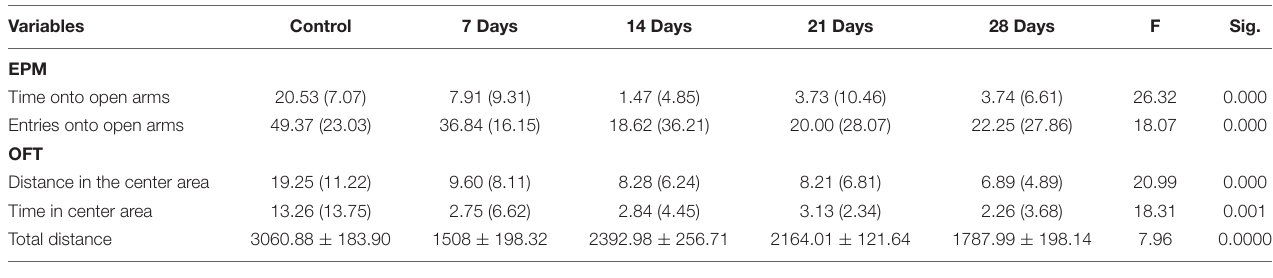
TABLE 2 | Basic data of FST and